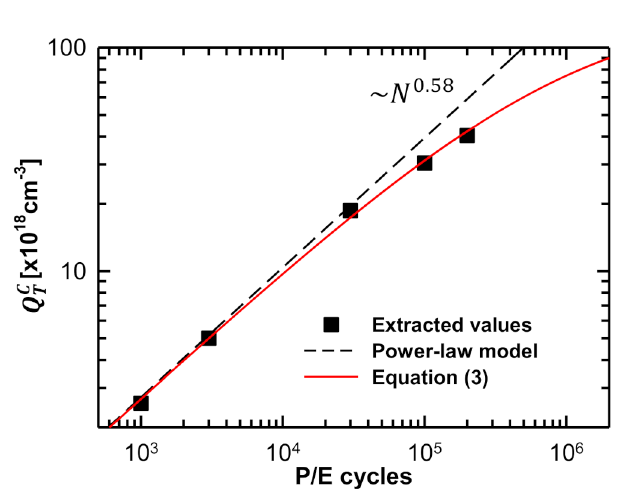
Figure 11. Comparison between extracted values (symbols) and model calculations (lines) according to Equation (3). Reprinted from [39].